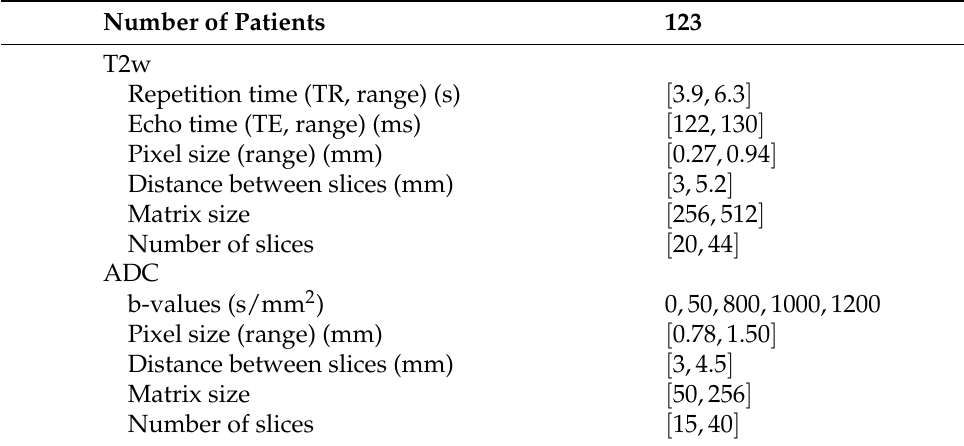
Table 3. Radical prostatectomy cohort data characteristics. Abbreviations: T2w—T2-weighted MRI; ADC—Apparent Diffusion Coefficient map. [ a , b ] indicates range between a and b